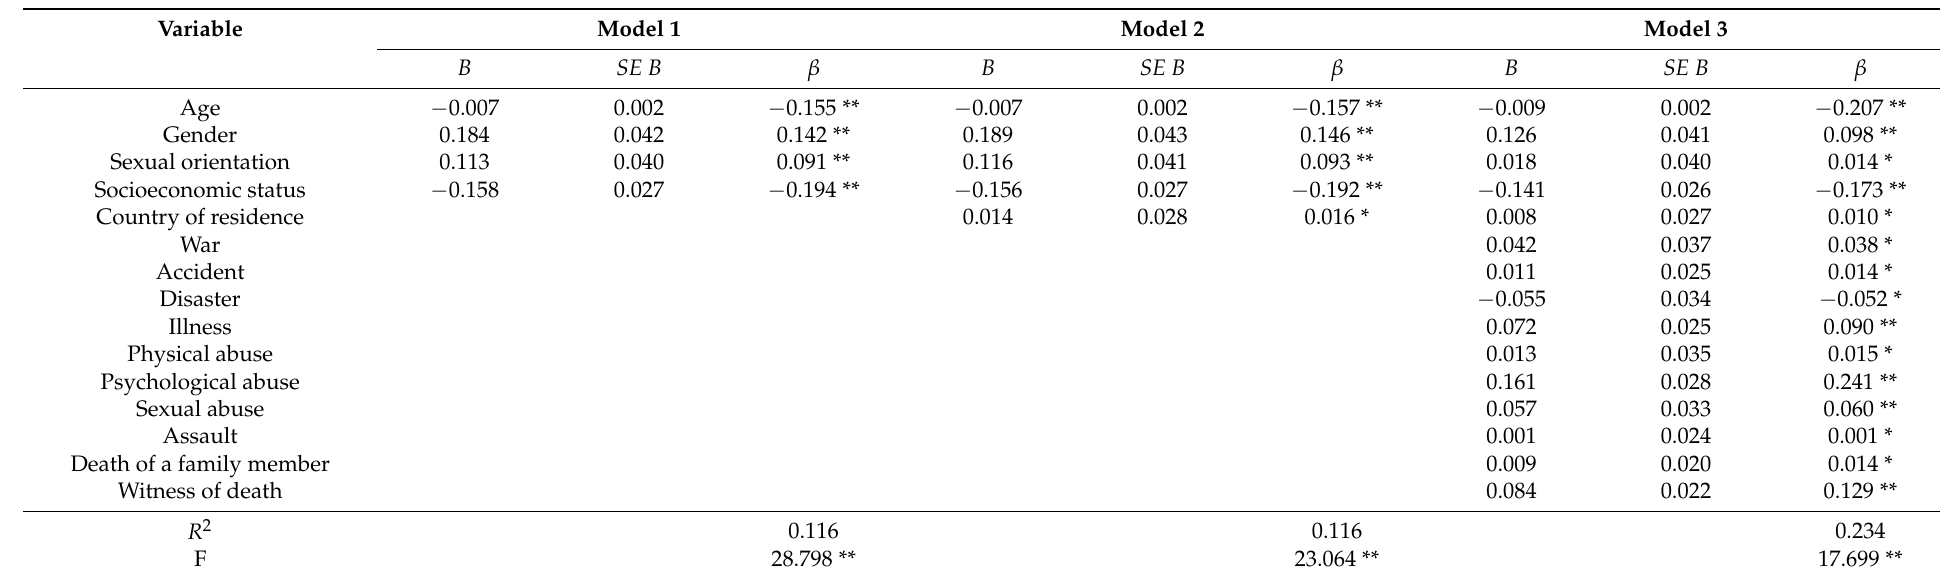
Table 5. Hierarchical linear regression analysis predicting mental